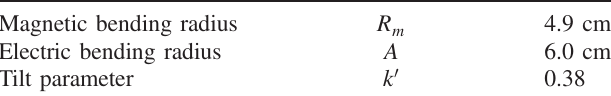
TABLE I. Belmont-Pabot parameters used by the C-inflectors.